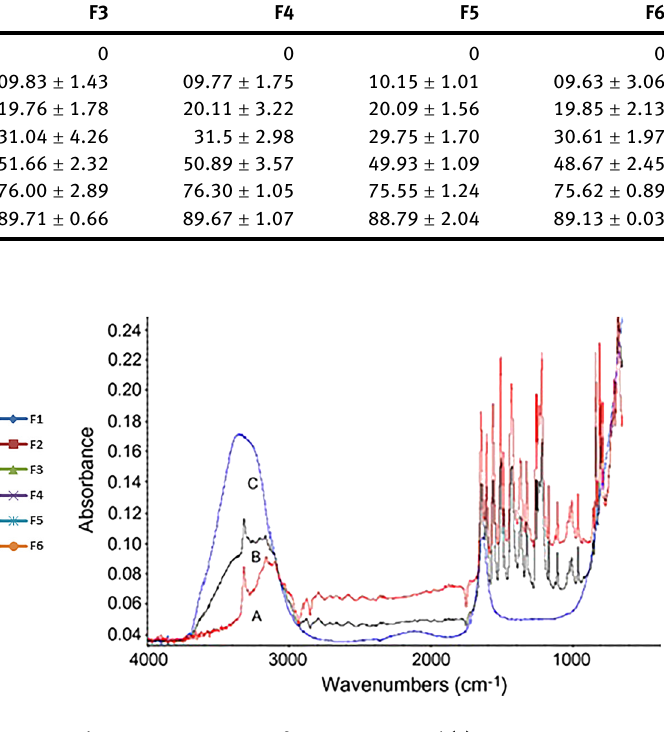
Figure 2: FTIR spectra of pure Paracetamol (A),